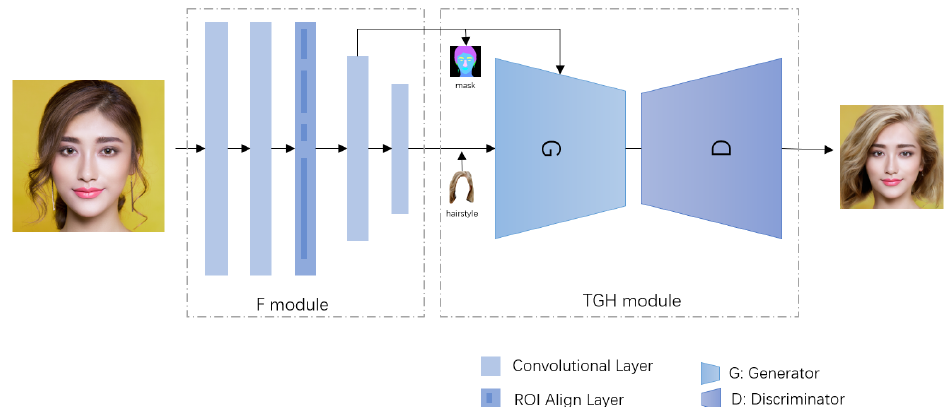
Figure 1. TGH Framework: Our proposed network comprises face segmentation (F) and transformer generative hairstyle (TGH) modules. The input image is extracted from the F module to extract the mask and detail features of the hairstyle and face. In the TGH module, the hairstyle image is referred to, and the face image with the new hairstyle is generated with the assistance of the mask image.